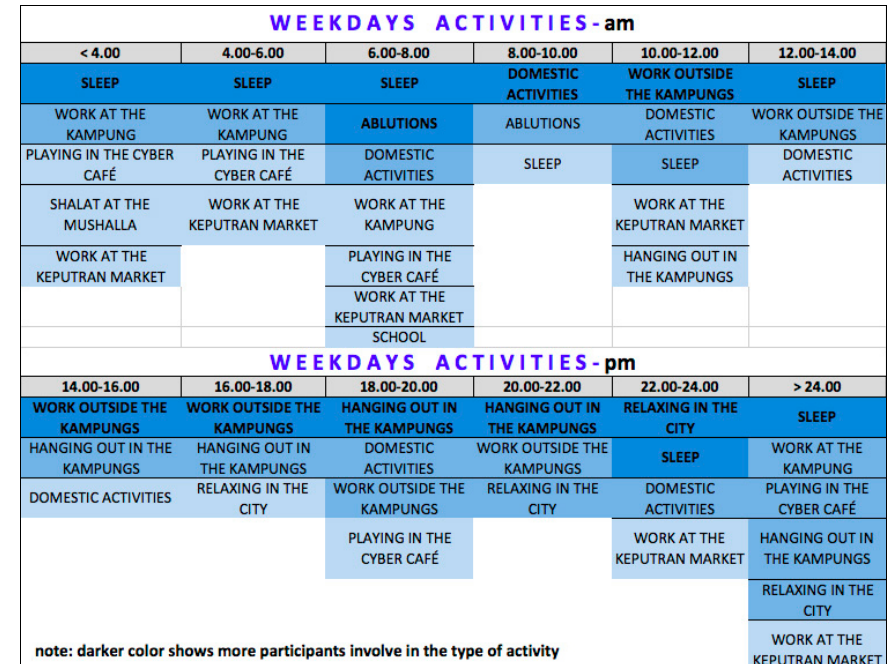
fig. 2. Time allocation and